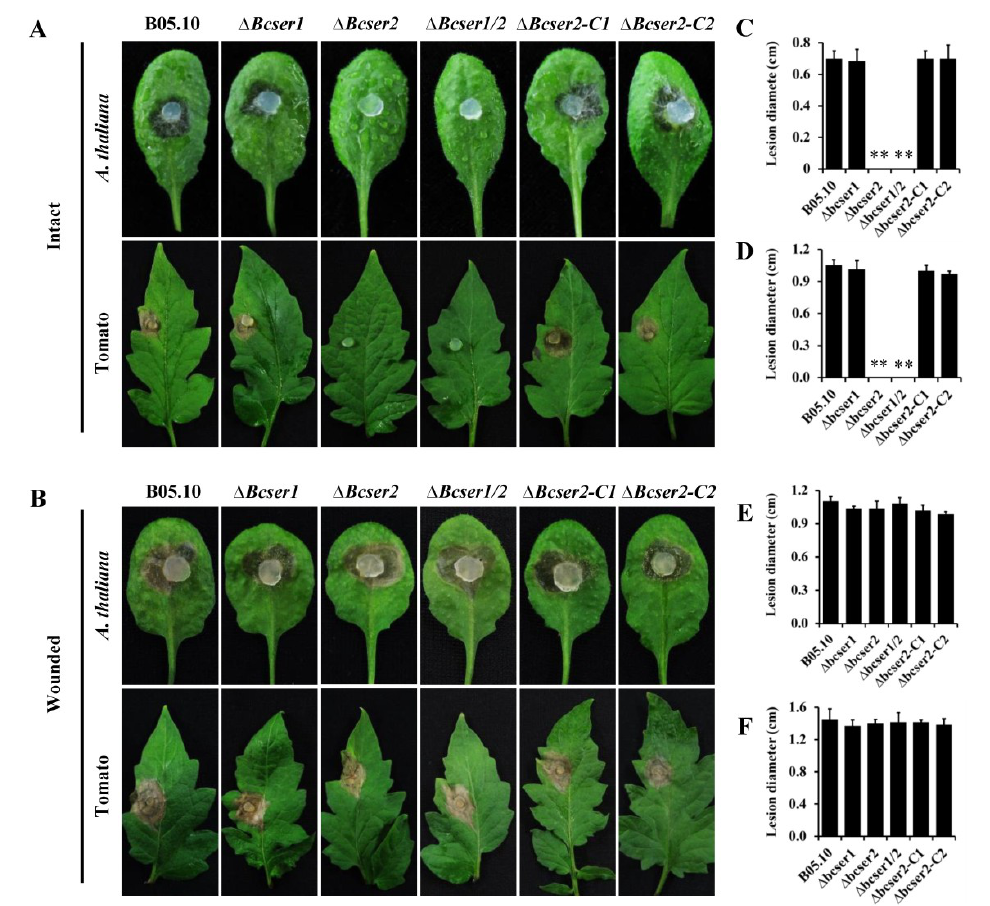
Figure 4. Virulence assays of mutants and wild-type strains on detached Arabidopsis and tomato leaves. ( A ) Intact leaves of Arabidopsis and tomato were inoculated with mycelial agar plugs (diameter = 3 mm) from the margins of actively growing colonies of deletion mutants ∆ Bcser1 , ∆ Bcser2, and ∆ Bcser1 / 2 , complemented mutants ∆ Bcser2-C1 and ∆ Bcser2-C2 , and wild-type strain B05.10 on PDA plates. Photographs were captured at 72 hpi. ( B ) Wounded leaves of Arabidopsis and tomato were inoculated with mycelial agar plugs (3 mm diameter) from the margins of actively growing colonies of the indicated strains on PDA plates. Detached leaves were wounded by a sterilized inoculation needle to make three small holes and mycelial agar plugs were inoculated onto the wound. For Arabidopsis and tomato, Photographs were captured at 24 hpi and 36 hpi, respectively. ( C ) Virulence on intact Arabidopsis leaves was evaluated based on lesion diameters. ( D ) Virulence on intact tomato leaves was evaluated based on lesion diameters. ( E ) Virulence on wounded Arabidopsis leaves was evaluated based on lesion diameters. ( F ) Virulence on wounded tomato leaves was evaluated based on lesion diameters. In all experiments, three independent replicates were performed each with 6 leaves from three plants. Values are presented as the means ± SE. Statistical significance is indicated in the graph (one-way ANOVA): **, p < 0.01.